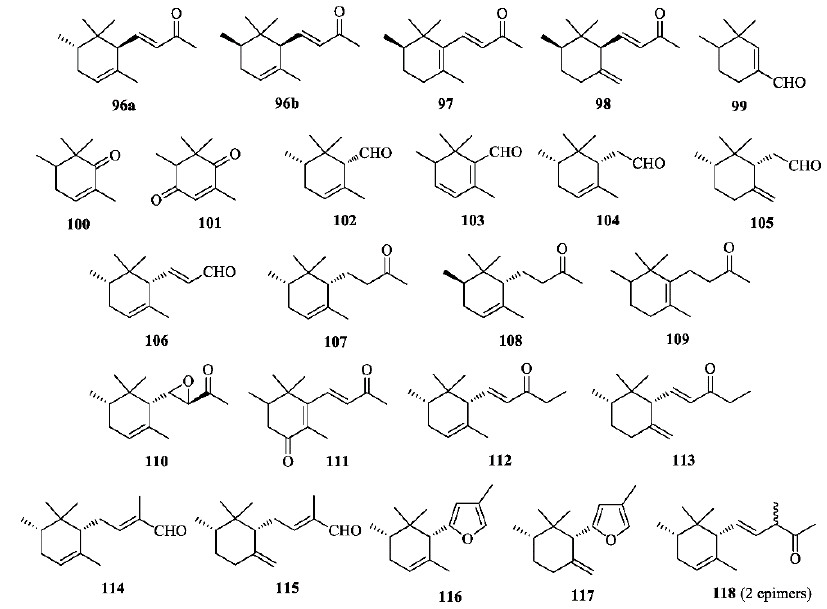
Figure 6. Irones and irone-related compounds isolated from Iris germanica .